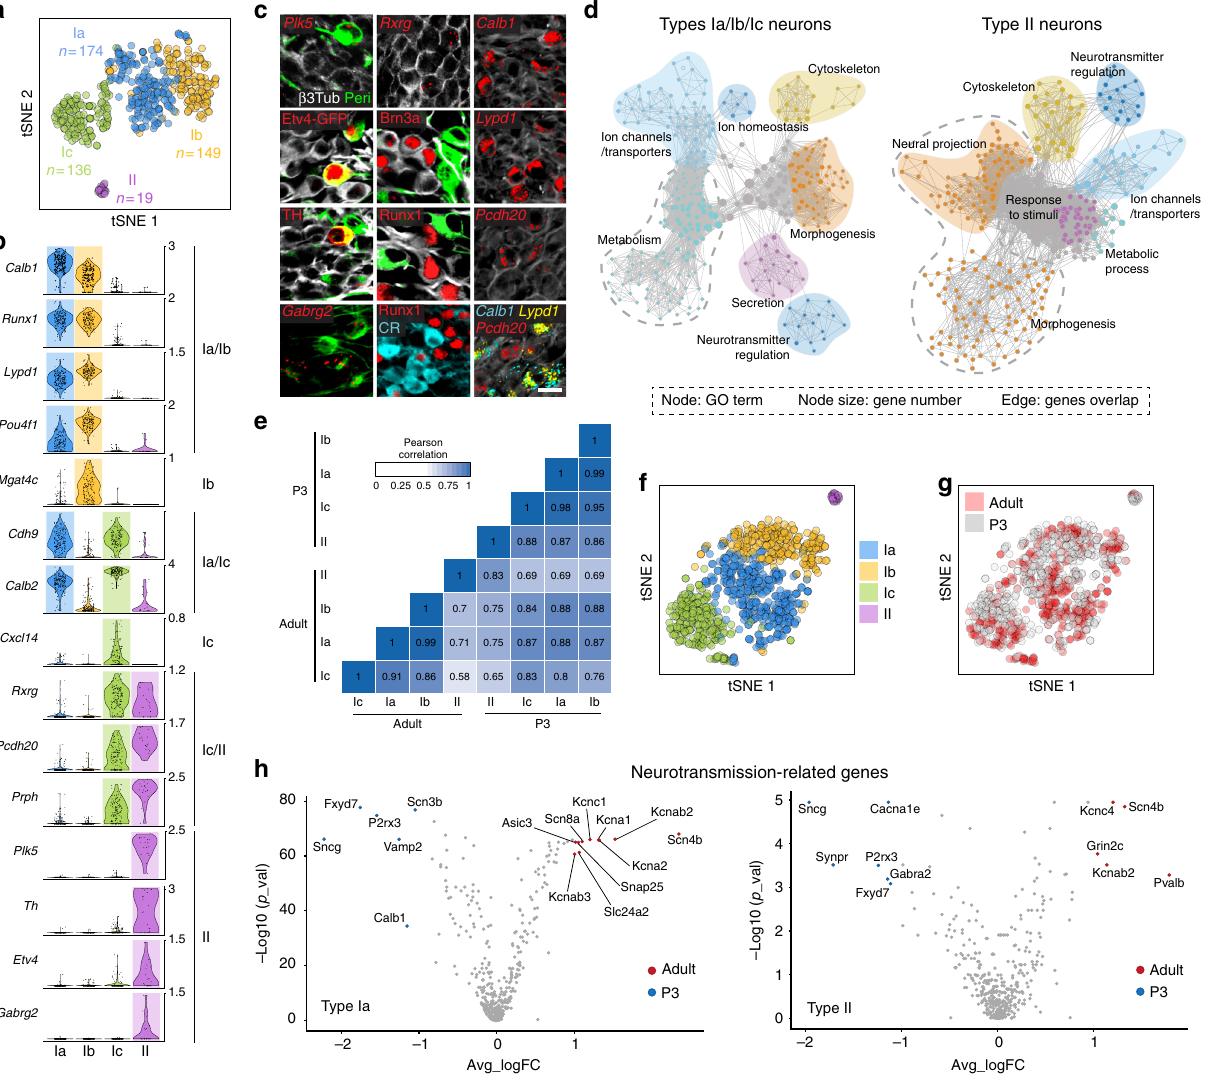
Fig. 6 SG neuron types in new born mice and comparative analysis of their transcriptome with adult SG neurons. a t-SNE of SG neurons showing four different clusters at P3. b Violin plots showing the expression of marker genes in log-transformed scale. c In vivo validation of the identi fi ed neuron types by immunohistochemical and fl uorescent in situ hybridization using identi fi ed marker genes in P3 cochlea. Type II SG neurons were identi fi ed by Peripherin (Peri), Plk5 , Etv4 ( Etv4 GFP transgenic mouse), TH, and Gabrg2 . Ia neurons were identi fi ed by Pou4f1 , Runx1, and CR. Ib neurons were identi fi ed by Runx1 and Pou4f1 and Ic neurons, by Rxrg , Pcdh20 , and CR expression. Lypd1 and Calb1 expression could not distinguish type Ia from Ib neurons at this stage. Note that co-localization on sections could never be observed for markers expressed in different populations of neurons in the scNRAseq data. d Gene set enrichment analysis of P3 type I and type II SG neurons visualized by network. e Correlation analysis of SG neuron types from adult and P3 stages, using average expression of all differentially expressed genes as input. f , g Visualization of SG neuron types from adult and P3 stages using tSNE, revealing the conserved subclass identities between the two samples. h Volcano plots of gene expression differences between adult and P3 SG neuron types for type Ia (top panel) and type II (bottom panel). Genes differentially expressed in adult or P3 are marked by red or blue dots respectively. Scale bar: 20 μ m ( c